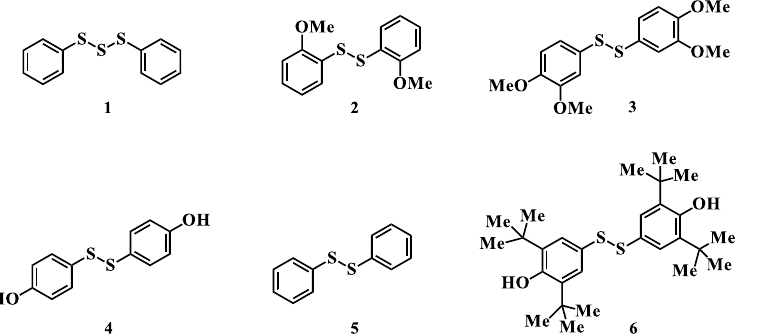
Figure 1. Structures of organosulfur compounds 1 – 6 : diphenyl trisulfide ( 1 ), bis(2-methoxyphenyl) disulfide ( 2 ), bis(3,4-dimethoxyphenyl) disulfide ( 3 ) , 4,4′ -dihydroxydiphenyl disulfide ( 4 ), diphenyl disulfide ( 5 ), bis(3,5-di- tert -butyl-4-hydroxyphenyl) disulfide ( 6 ).